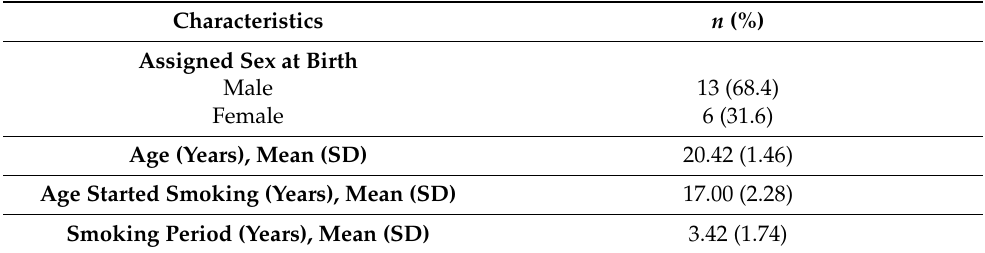
Table 1. Characteristics of the 19 participants at the time of